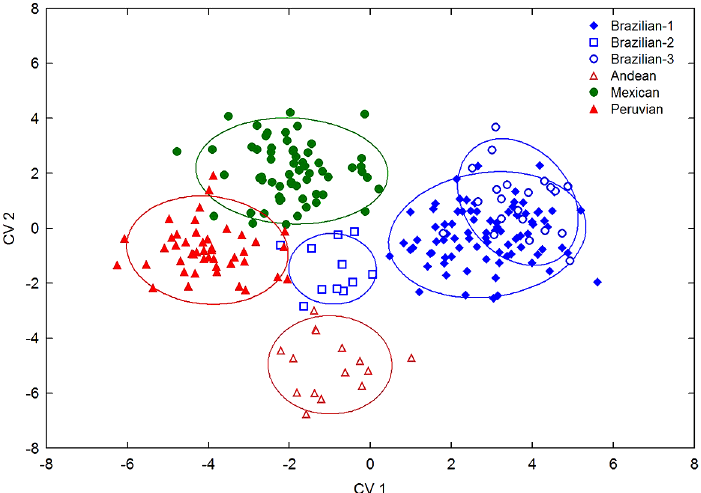
Figure 6. Canonical variates analysis (CVA) of wing shape. Plot of the first two canonical variates that resulted from the analysis of wing shapes from 19 population samples. The CVA analysis was used to test the hypothetical groups by morphotype. Confidence ellipses 95%.